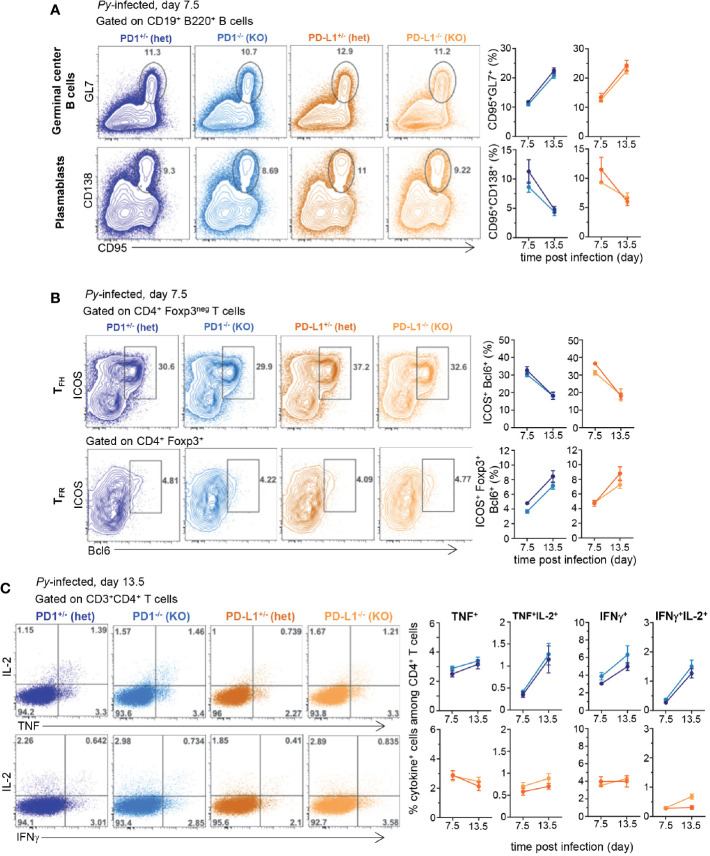
B and CD4+ T cell responses are comparable in Plasmodium yoelii-infected PD1-/-, PD-L1-/-, and heterozygous counterparts littermates. Littermates of indicated genotypes were inoculated with 2x105
Py 17XNL1.1 (iRBC) i.v. (A) Spleens from Py-infected mice were harvested 7.5 and 13.5 days post infection and stained for CD19, B220, GL7, CD138, CD95 to monitor B cell responses and (B) spleen cells were stained for CD4, CD3, Foxp3, Bcl6, ICOS to monitor CD4+ TFH and TFR cellular responses by flow cytometry. (C) Spleen cells from either uninfected, day 7.5 or 13.5 Py-infected (2x105 iRBC, i.v.) PD-1-/- (KO), PD-1+/- (hets), PD-L1-/- (KO), PD-L1+/- (hets) mice were incubated with PMA/ionomycin for 4 h and then stained for cell-surface CD3, CD4 and CD8 and intracellular cytokines IL-2, IFNγ, and TNF. Frequencies of cytokine-producing cells among indicated T cell subset are shown. In all experiments, representative FACS dot plots of two independent replicate experiments are presented (n=3–12). Graphs show average results from experiments with SEM. Student t-test was conducted between groups and p-values are indicated when applicable.